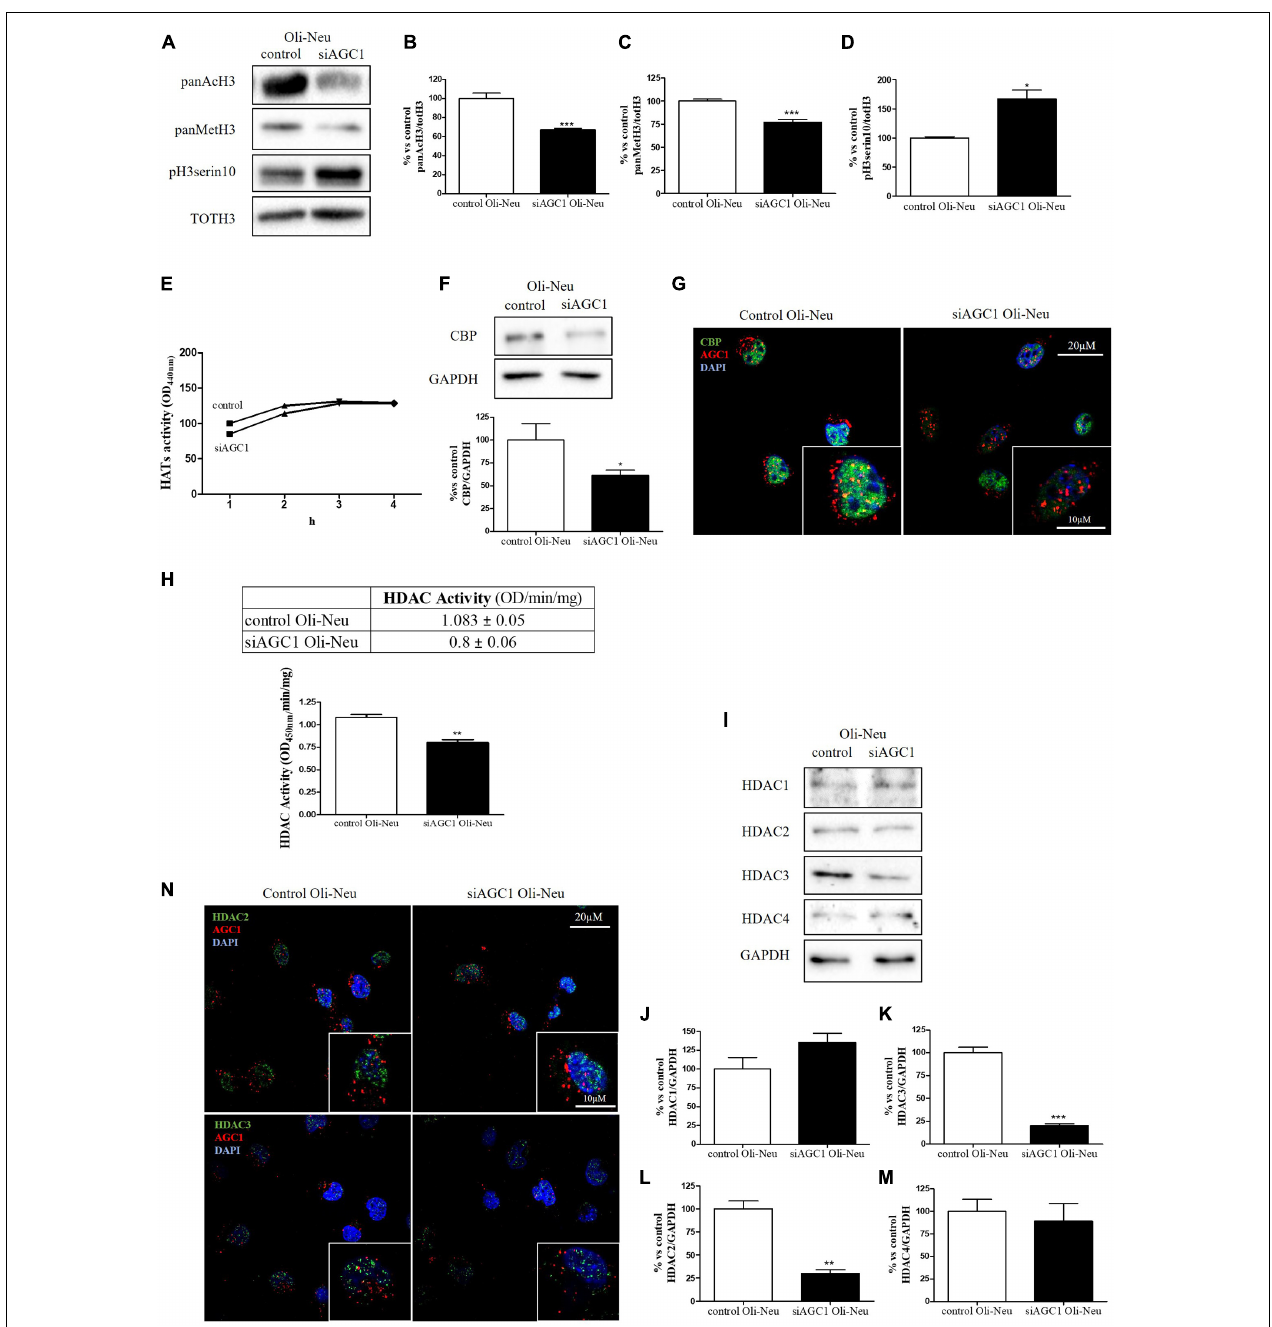
FIGURE 3 | Altered histone PTMs, HAT CBP, and HDAC isoforms expression/activities in AGC1-silenced Oli-Neu cells. WB analysis and relative densitometries of panAcH3 (A,B) , panMetH3 (A,C) , pH3 (A,D) , CBP (F) , HDAC1 (I,J) , HDAC2 (I,K) , HDAC3 (I,L) and HDAC4 (I,M) expression in Oli-Neu cells; GAPDH was used for endogenous normalization. Activity assay of CBP (E) and HDAC (H) in Oli-Neu cells. Histone deacetylases (HDACs) activity mean ± SEM of control Oli-neu: 1.083 ± 0.0535, Mean ± SEM of siAGC1 Oli-neu: 0.8000 ± 0.0608, N = 3. Difference between means 0.2830 ± 0.04676. Confocal microscopy images (100X) of CBP (G) and HDAC2 and HDAC3 (N) (green) and AGC1 (red) in Oli-Neu cells; nuclei were labeled with DAPI. 20 and 10 µ m scale bar. Values are mean ± SD of at least 3 independent experiments; *** p < 0.001, ** p < 0.01, * p < 0.05, compared to control; Student’s t -test.